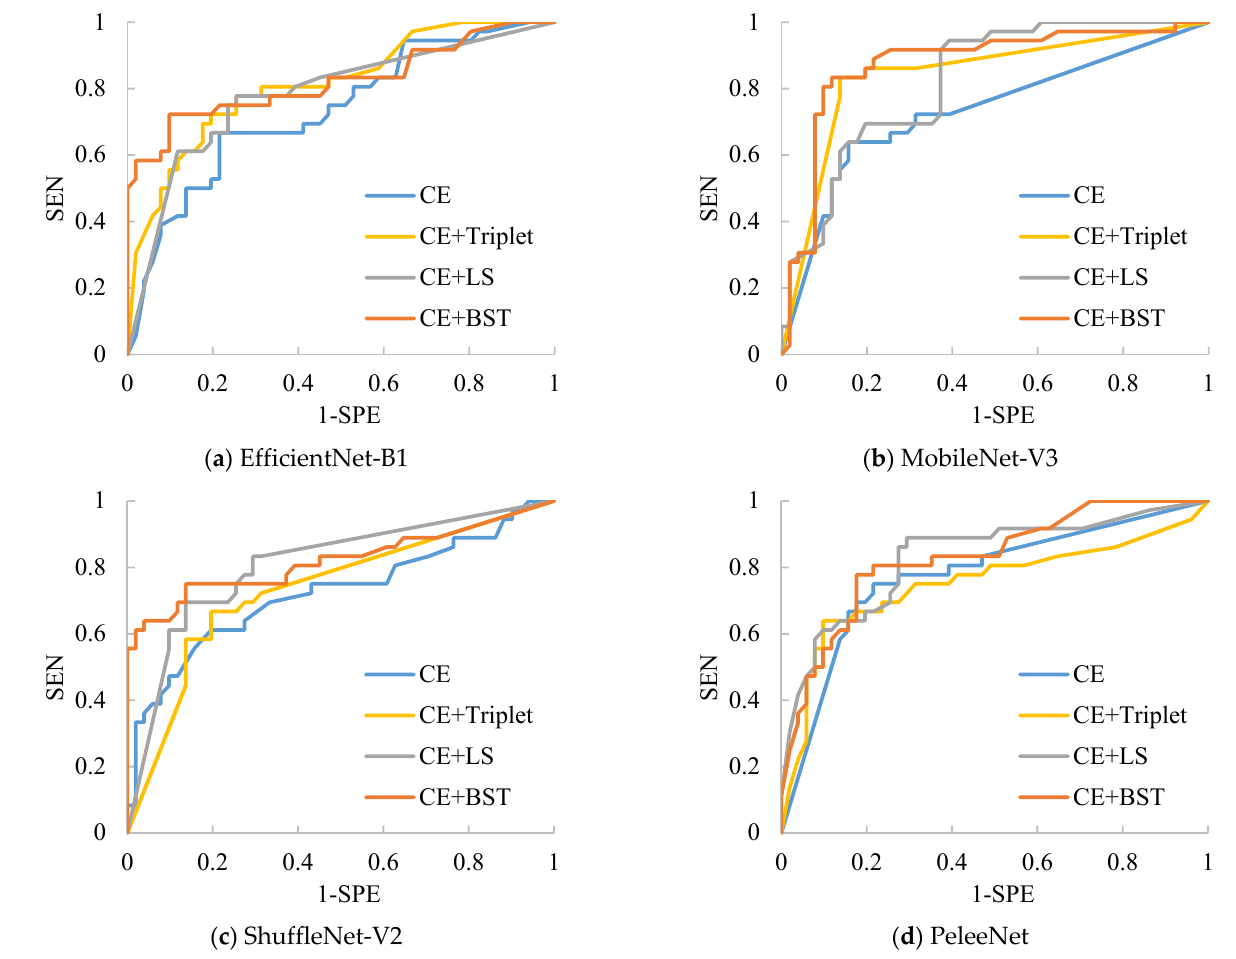
Figure 13. ROC curves for the compared networks with different losses on the rash image dataset. Table 8. Metrics for the compared networks on the rash image dataset.